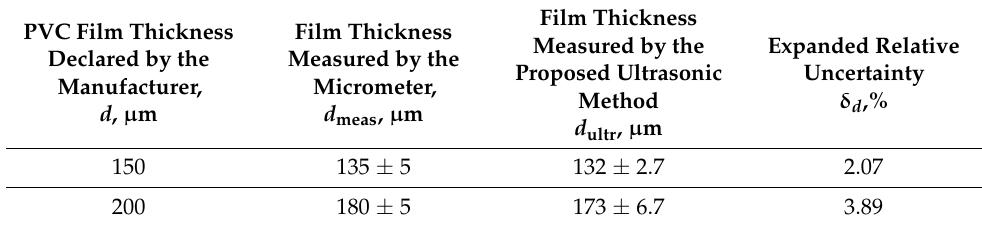
Table 2. Calculation results of the PVC film thickness.